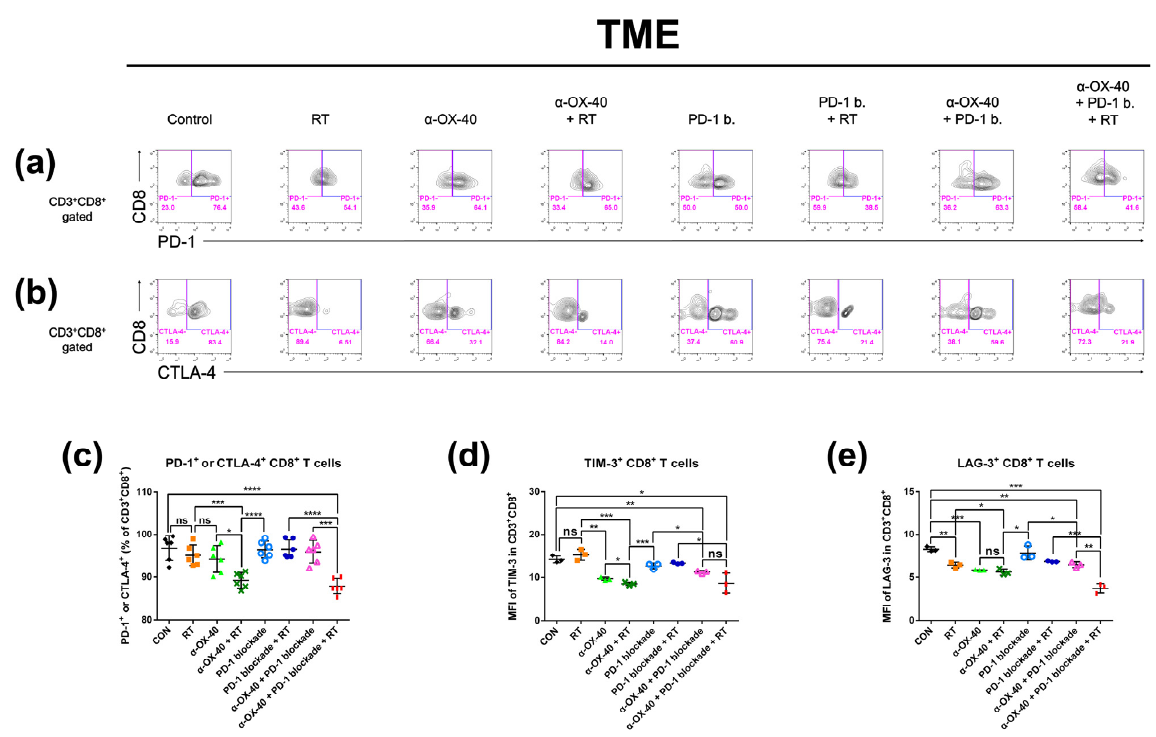
Figure 4. Expression of exhaustion markers on CD8+ T cells in the tumor microenvironment. The percentage of CD8+ T cells expressing exhaustion markers (PD-1, CTLA-4, TIM-3, and LAG-3) was calculated by flow cytometry. Representative flow cytometry plots of ( a ) PD-1+ or PD-1- and ( b )